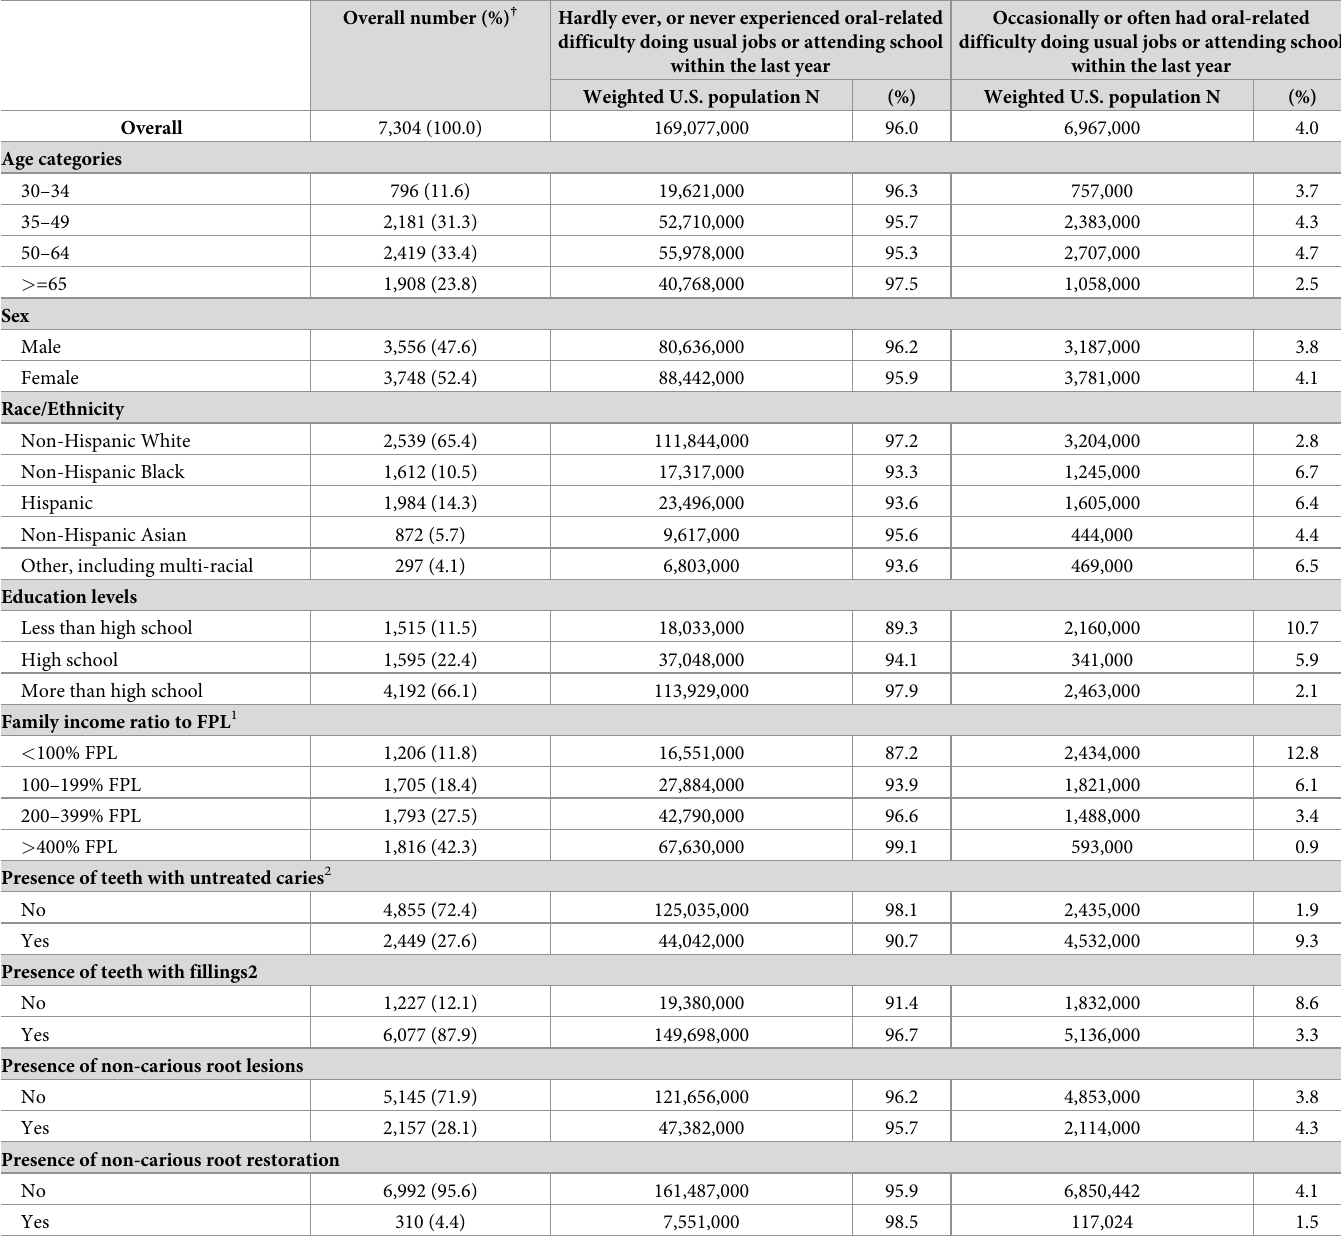
Table 3. Demographics and prevalence of oral related-productivity loss among adults aged � 30 years who completed the dental examination and at least the first 24-hour dietary recall interview, had at least one natural tooth, and provided an answer about their oral-related productivity loss in the National Health and Nutri- tion and Examination Survey (NHANES);